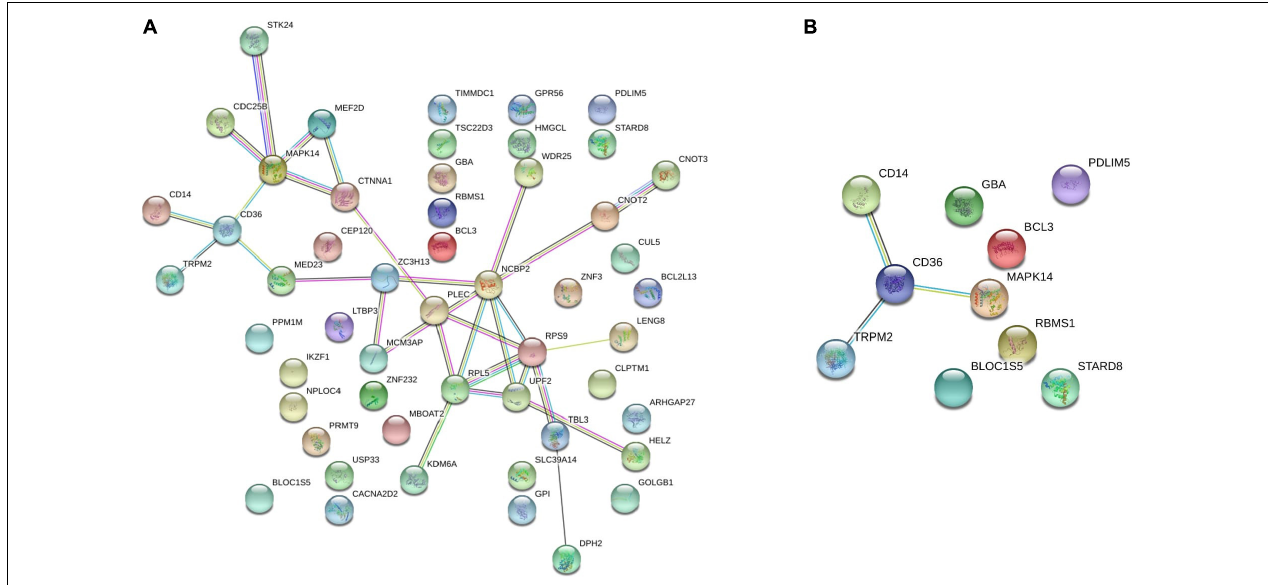
FIGURE 5 | The protein–protein interaction network of (A) the 55 intersecting genes between familial hyperlipidemia (FH) and familial coronary heart disease (FH-CHD) groups, and (B) in 10 genes selected from the 55 intersecting genes using web-based bioinformatics tool: functional protein association networks